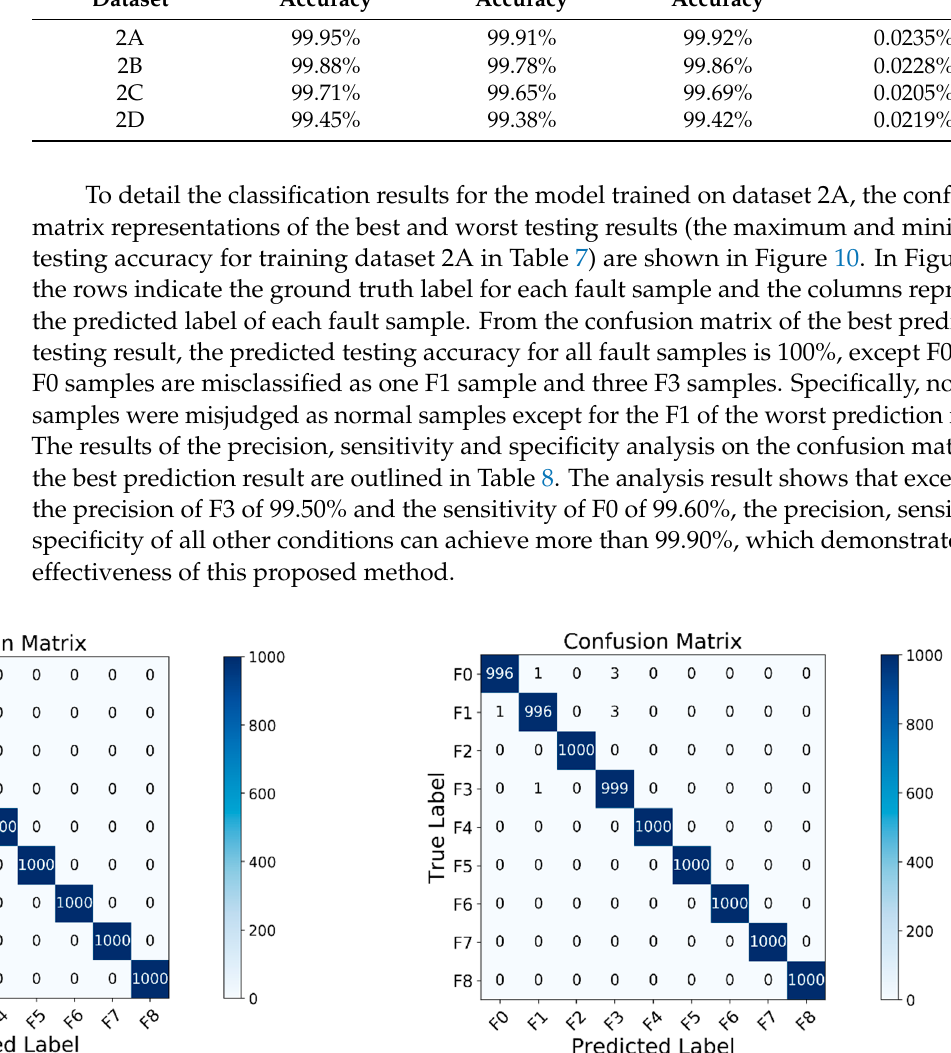
Table 7. The testing result of the proposed WAR-DIC model in different imbalance training datasets.